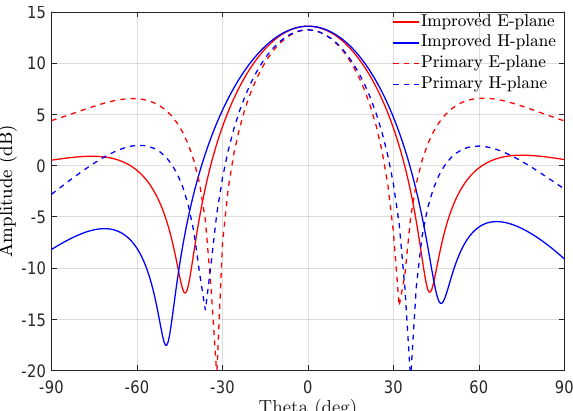
Figure 4. Simulated reflection coefficient and gain for the improved (red line) and primary (blue line) 2 × 2 subarrays.